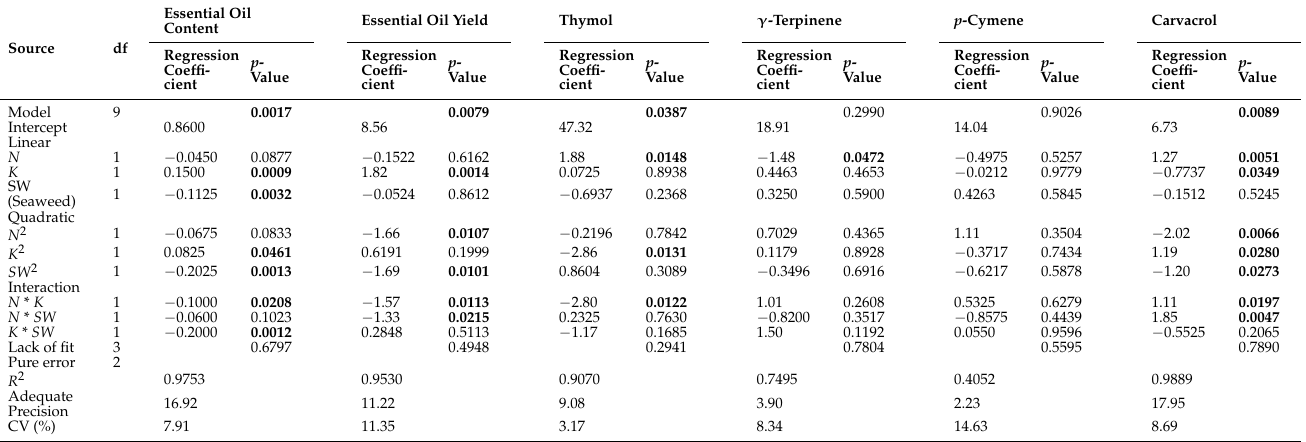
Table 5. Analysis of variance, regression coefficients, and adequacy criteria of the fitted models for essential oil content and yield, thymol, γ -terpinene, p -cymene, and